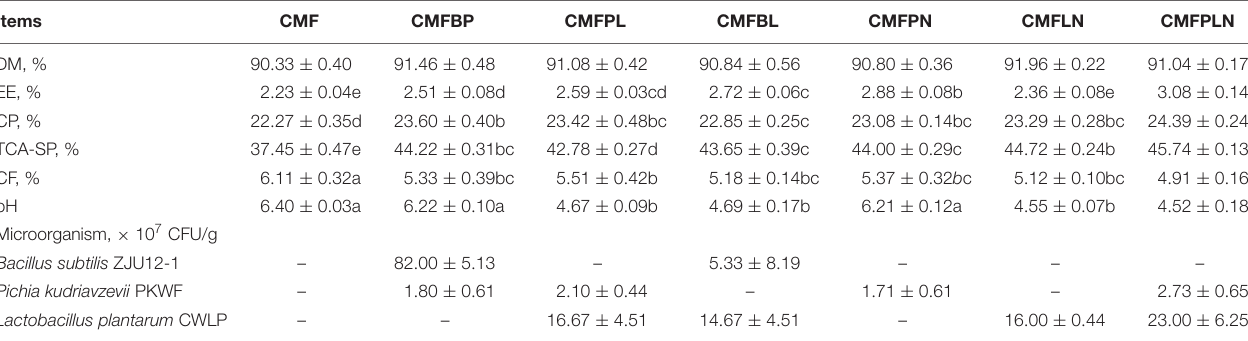
TABLE 1 | Nutrient composition and microorganisms of corn byproducts mixture feed (CMF) and CMF fermented with different microbes and neutral protease (as air-dry basis). Items CMF CMFBP CMFPL CMFBL CMFPN DM, % 90 . 33 ± 0 .